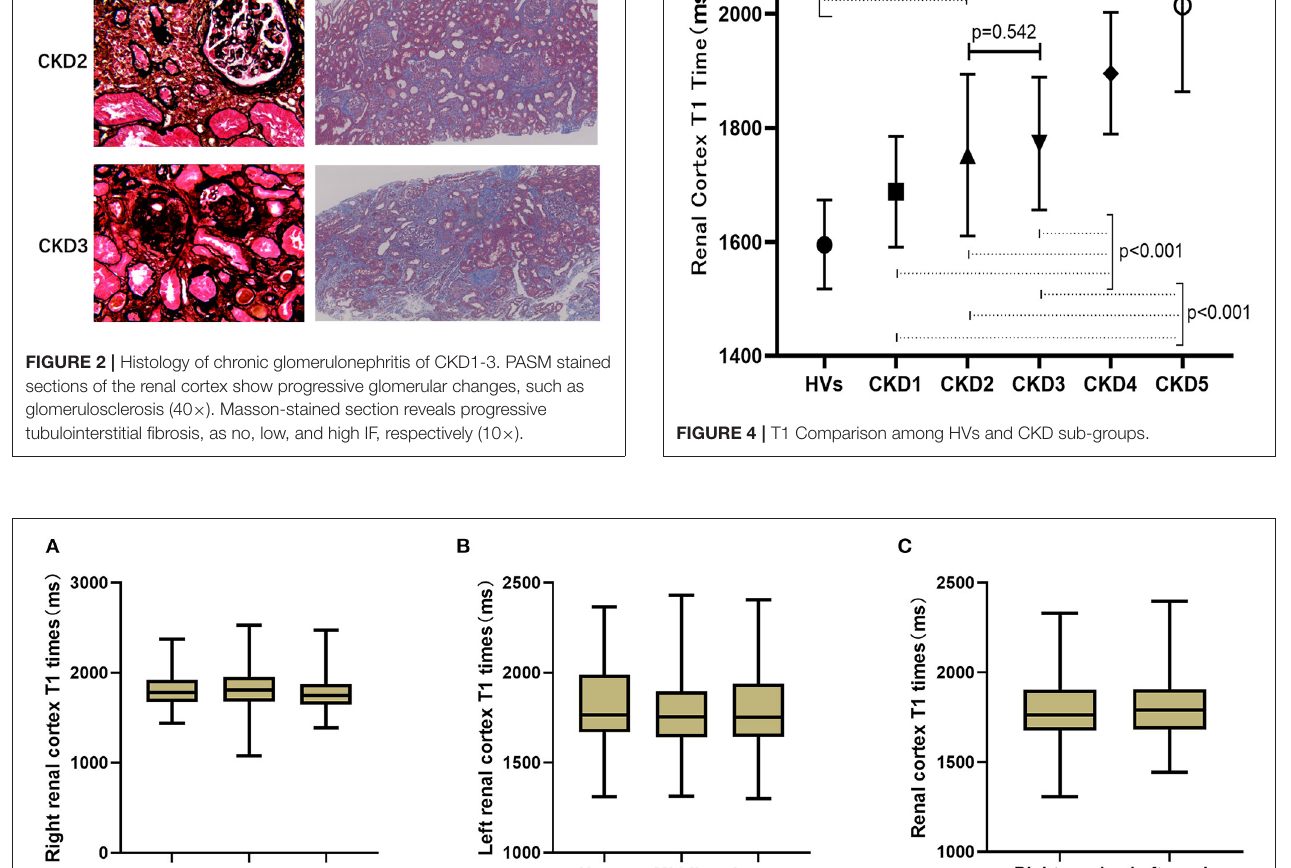
Frontiers in Medicine |